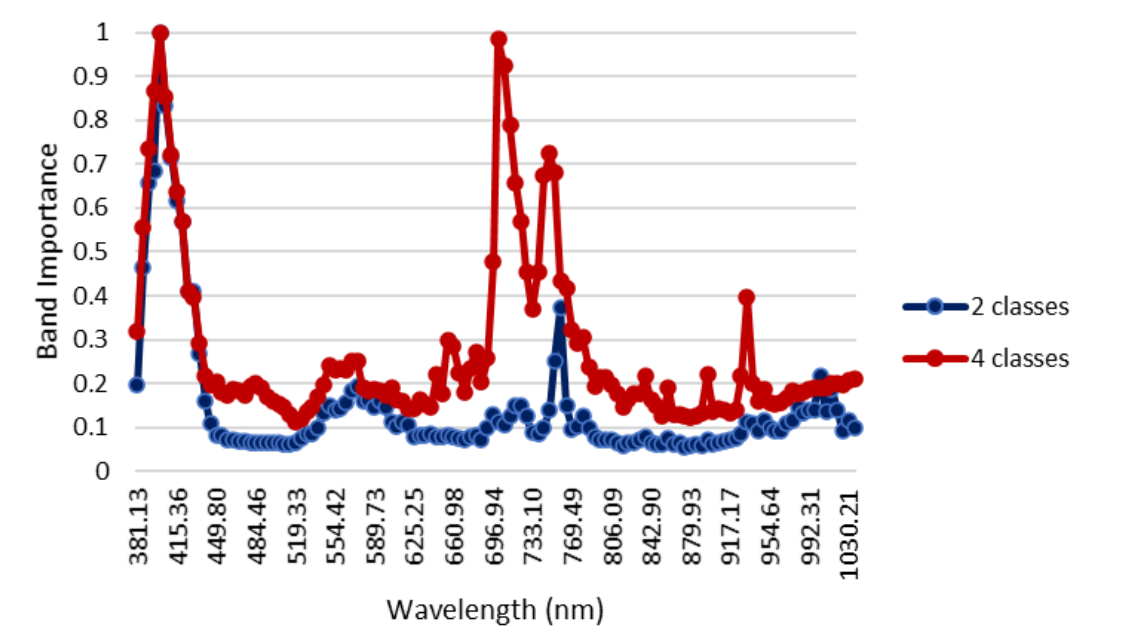
Figure 13. Band importance determined by RF on the maximum tuberization phenological stage.